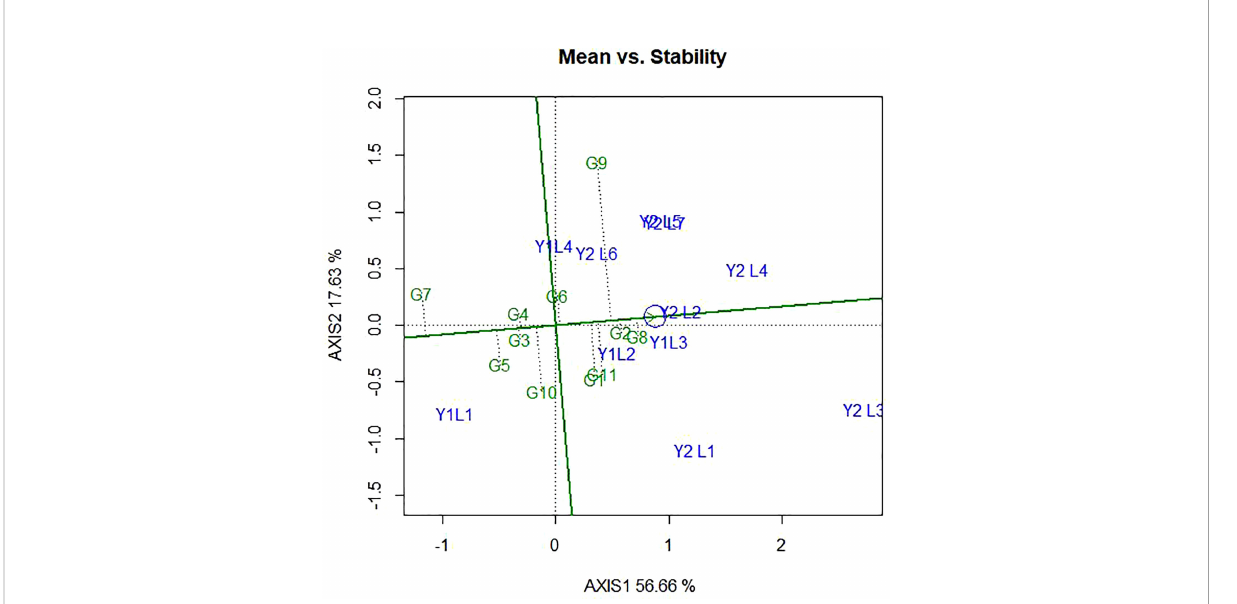
FIGURE 7 The ‘‘ Mean vs. stability ’’ pattern of GGE biplot illustrating interaction effect of 11 soybean genotypes under two years (11environemnets) for grain yield per hectare. The biplots were created based on Centering = 0, SVP = 2, Scaling =